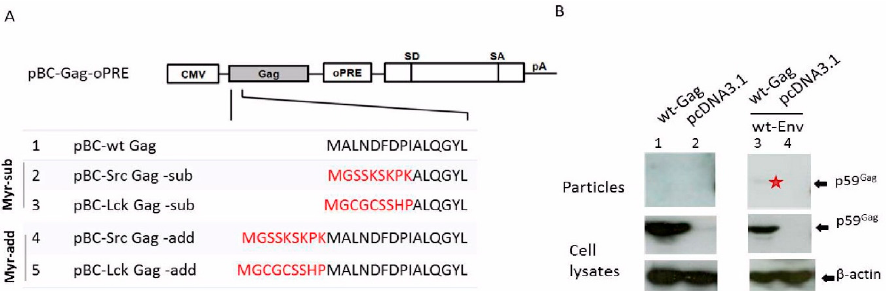
Figure 3. Low levels of BFV Gag ‐ Env subviral particle release. ( A ) Cloning scheme of BFV wt and myr Gag expression clones. Myristoylation signals (marked in red) derived from the human cellular proteins Src and Lck were added onto ( ‐ add) or replaced ( ‐ sub) part of the N ‐ terminus of BFV Gag in the BFV Gag expression plasmid pBC ‐ BFV ‐ Gag ‐ oPRE. The positions of the CMV ‐ IE promoter, the oPRE, a non ‐ coding heterologous SD and SA site and a poly ‐ adenylation site (pA) are indicated [39]. ( B ) Budding of BFV Gag, alone or together with Env, was analyzed by transfecting HEK293T with the parental wt BFV Gag expression plasmid pBC ‐ BFV ‐ Gag ‐ oPRE alone (lane 1) or together with pBC ‐ BFV ‐ Env (lane 3). The empty vector pcDNA3.1 was used as a negative control (lanes 2 and 4). Two days post ‐ transfection, cell lysates and supernatants were harvested. Equal protein aliquots of cell lysates and subviral particles in supernatant were separated by SDS ‐ PAGE and visualized using a BFV Gag MA antiserum. The position of the Gag precursor (p59) is indicated. The faint band in line 3 is marked with an asterisk. Proper protein loading was determined by probing for β‐ actin.